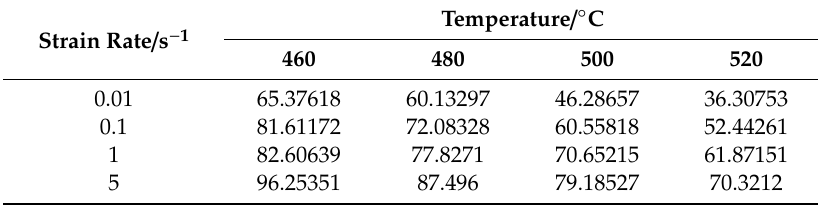
Figure 3. True strain–stress curves at different strain rates: ( a ) 0.01 s −1 ; ( b ) 0.1 s −1 ; ( c ) 1 s −1 ; ( d ) 5 s −1. Table 2. Peak stress at different hot-processing parameters (MPa).